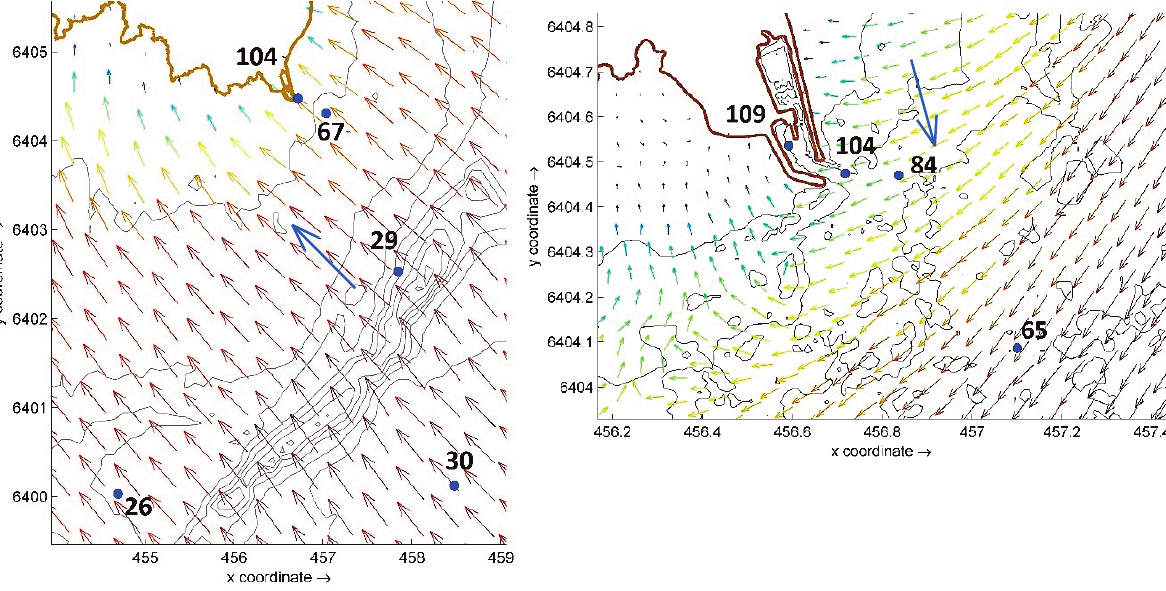
Fig. 4. The wave model grid points for data used in Fig. 4 and in Figs 5–7. Left panel: third-level grid, wind from the direction of 135°. Right panel: innermost fourth-level grid, wind from the direction of 345°. The wave pattern is presented for a wind speed of 15 m/s. The blue large arrows indicate the wind direction. The wave height is represented by colour (brown and red: the highest, yellow: medium, green and blue: lower waves) and the length of small arrows while the wave direction is indicated by the direction of small arrows. The scale is presented in